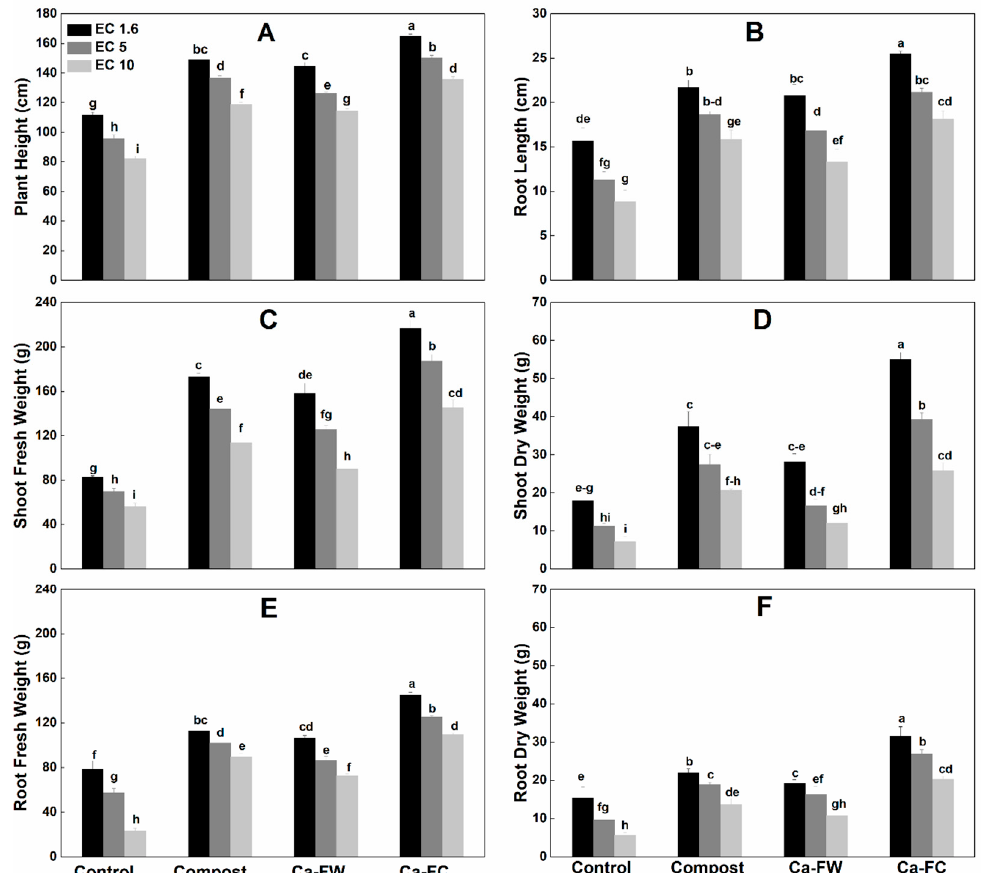
Figure 1. Effect of compost, Ca-based fertilizer industry waste (Ca-FW), and Ca-fortified compost (Ca-FC) on growth parameters of maize ( Zea mays L.) under saline–sodic soil conditions. (Note: EC = electrical conductivity. Quantities sharing similar letters are statistically different from each other at p ≤ 0.05).